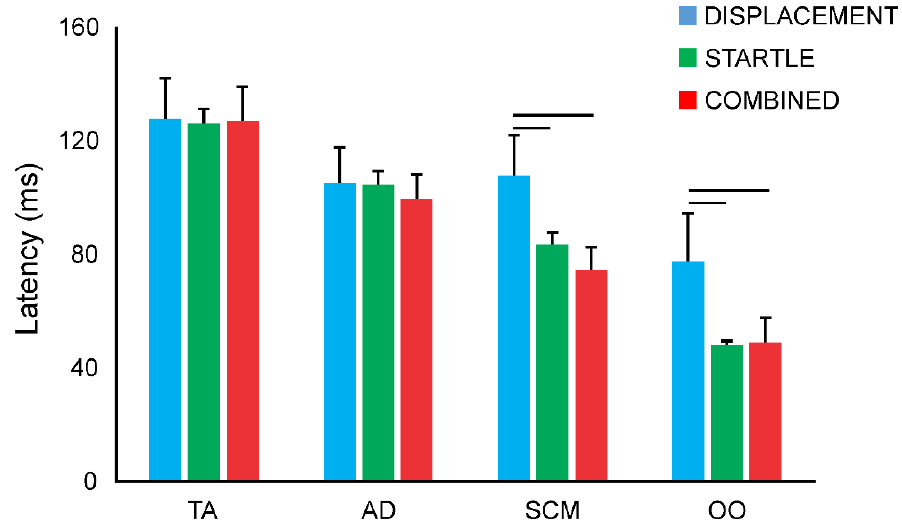
Figure 9. Mean (SE) onset latency for responses evoked in the respective muscle across all stimuli of the specific mode. Horizontal lines connect differences identified by Bonferroni adjusted, post hoc t -tests ( p < 0.05). TA, tibialis anterior; AD, anterior deltoid; SCM, sternocleidomastoid; OO, orbicularis oculi.